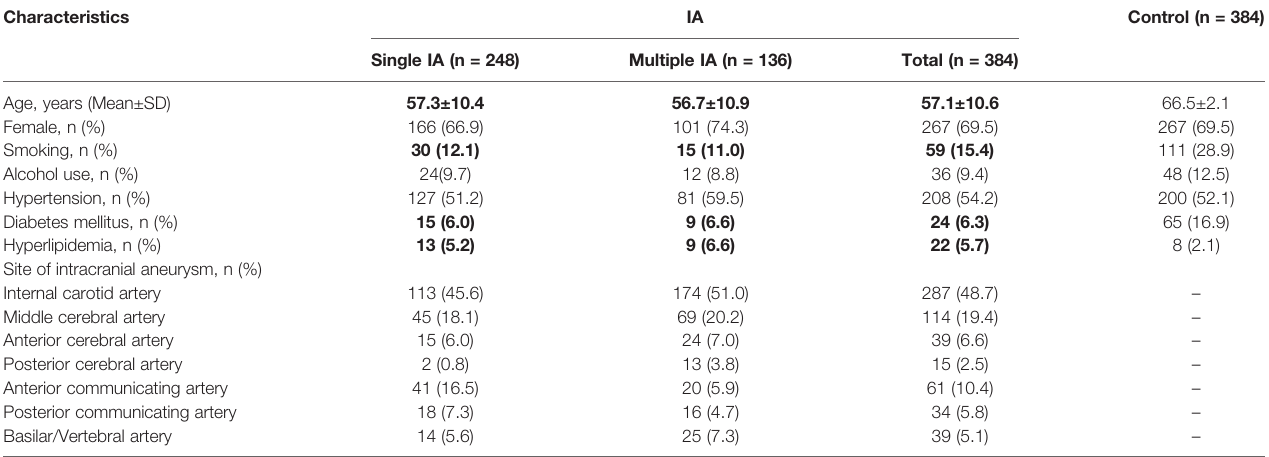
TABLE 2 | Characteristics of the study